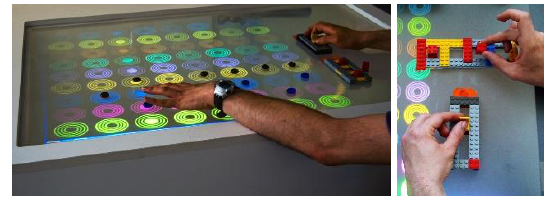
Figure 5. Drum Sequencer game. Left: tabletop overview with tokens distributed on the virtual drum score. Right: detail of the Beat Store toy (up) and the Speed fader (down).